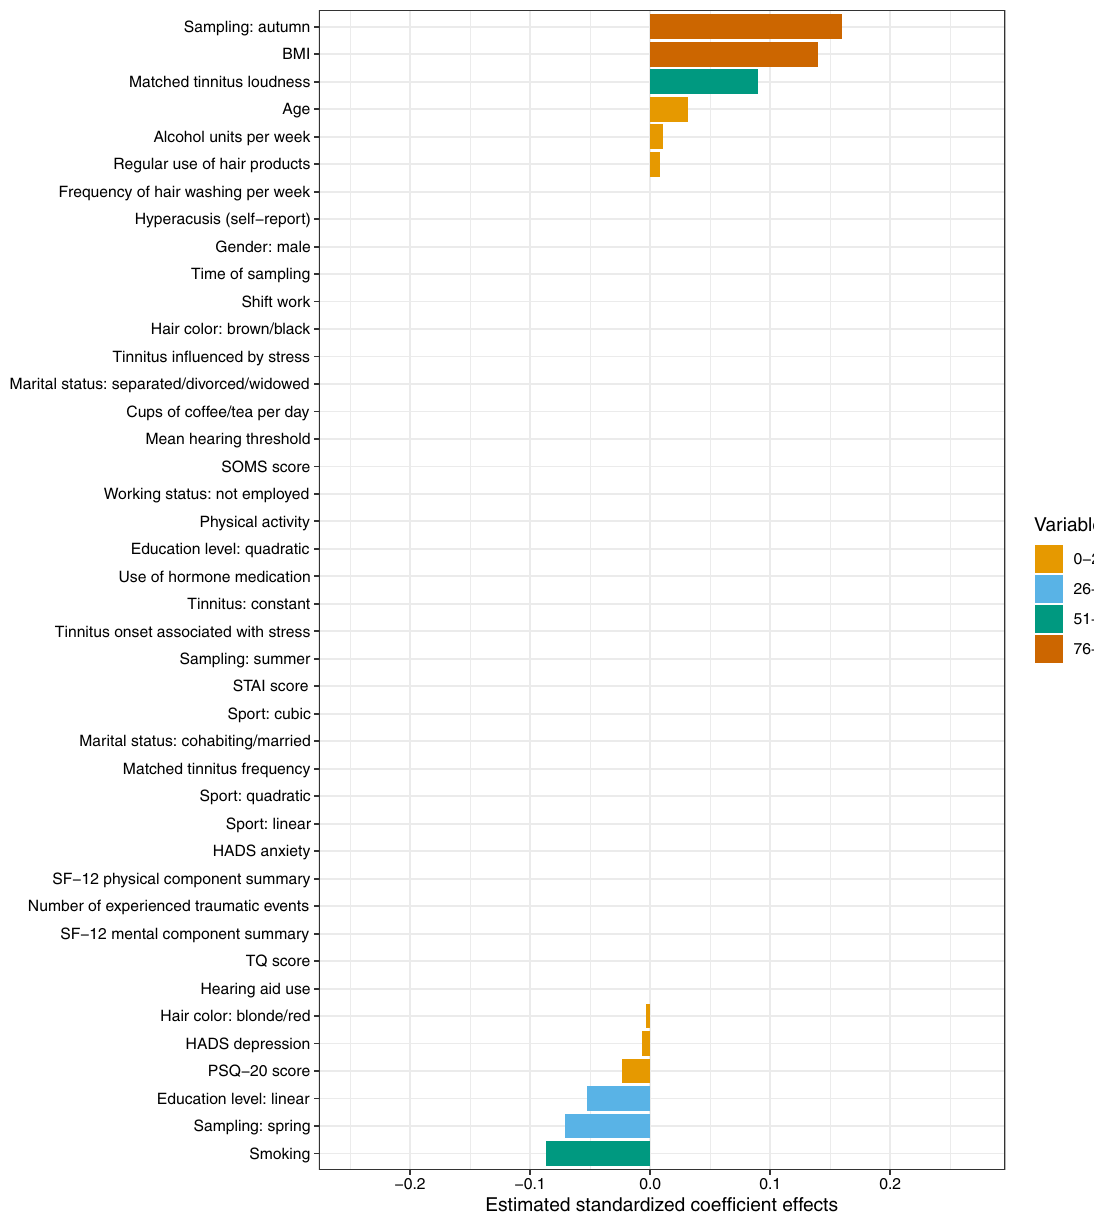
Figure 2. Estimated standardized coefficient effects by elastic net regression with n-fold cross-validation for the prediction of hair-cortisol in chronic tinnitus patients (training data: N = 66). BMI Body-Mass-Index; HADS Hospital Anxiety and Depression Scale; PSQ‑20 Perceived Stress Questionnaire (20 item version); SF‑12 Short Form-12 Health Survey; SOMS Screening of Somatoform Disorders; STAI State-Trait Anxiety Inventory (State Anxiety); TQ Tinnitus